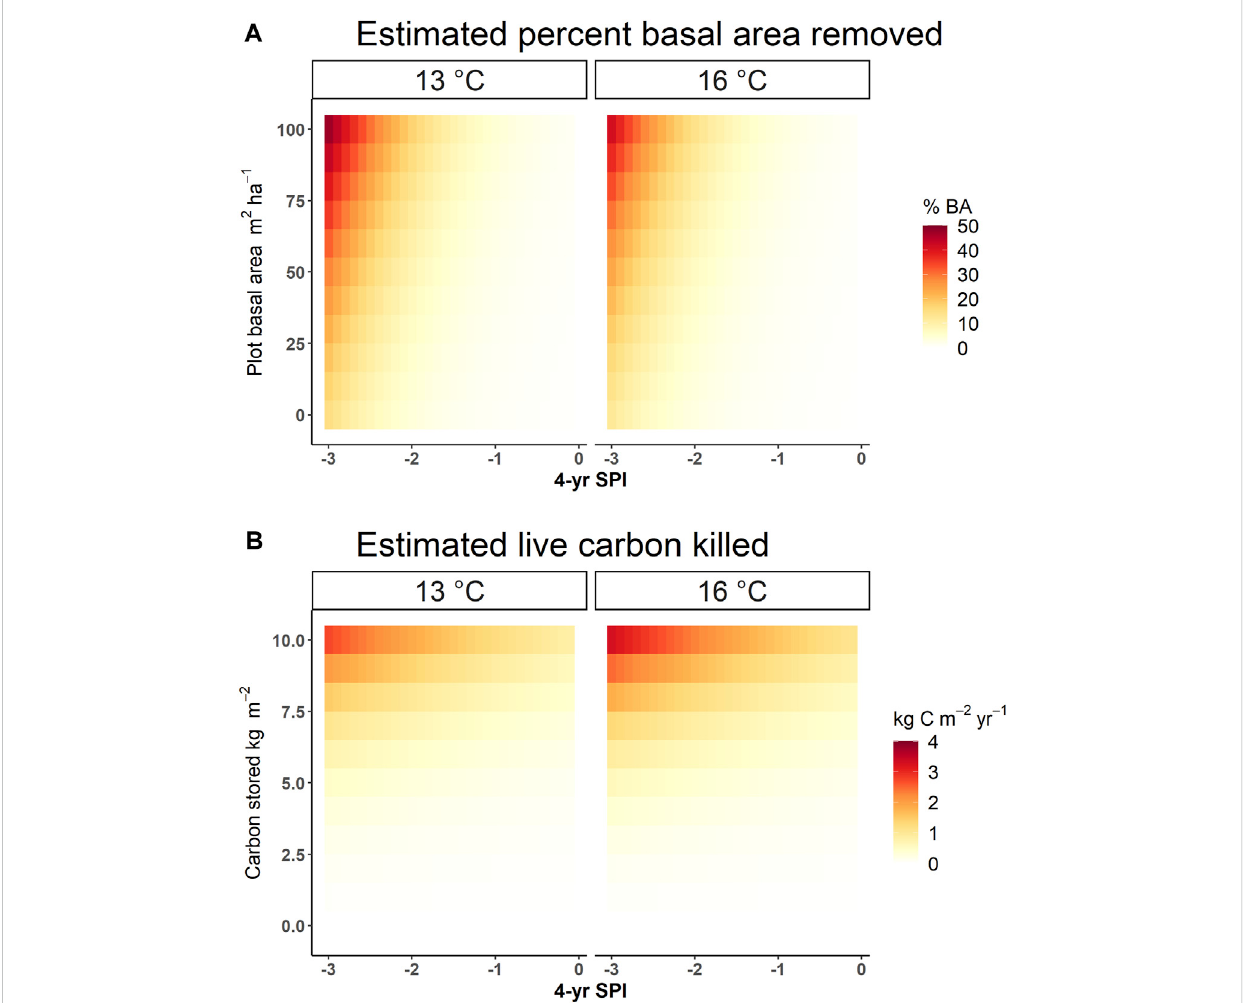
FIGURE 6 Heatmapofbasalareaandlivecarbonkilledprobabilitiesbasedon4-yearstandardprecipitationindex(4-yearSPI)andplotstatus. (A) thepercentof ponderosa pine ( Pinus ponderosa ; PIPO) basal area killed on average at a given initial plot basal area (m 2 ha -1 ) and 4-year SPI; (B) . Ribbons represent the 95% CI of all models undereach scenario. The estimate of live carbon killed (kg m -2 yr -1 ) isbased on theamount of carbon stored ina stand the year prior and the SPI-4 years. Each estimate averages across various plots and only for a single year. Models estimated from the simulation run on both emissions scenarios for all 18 climate